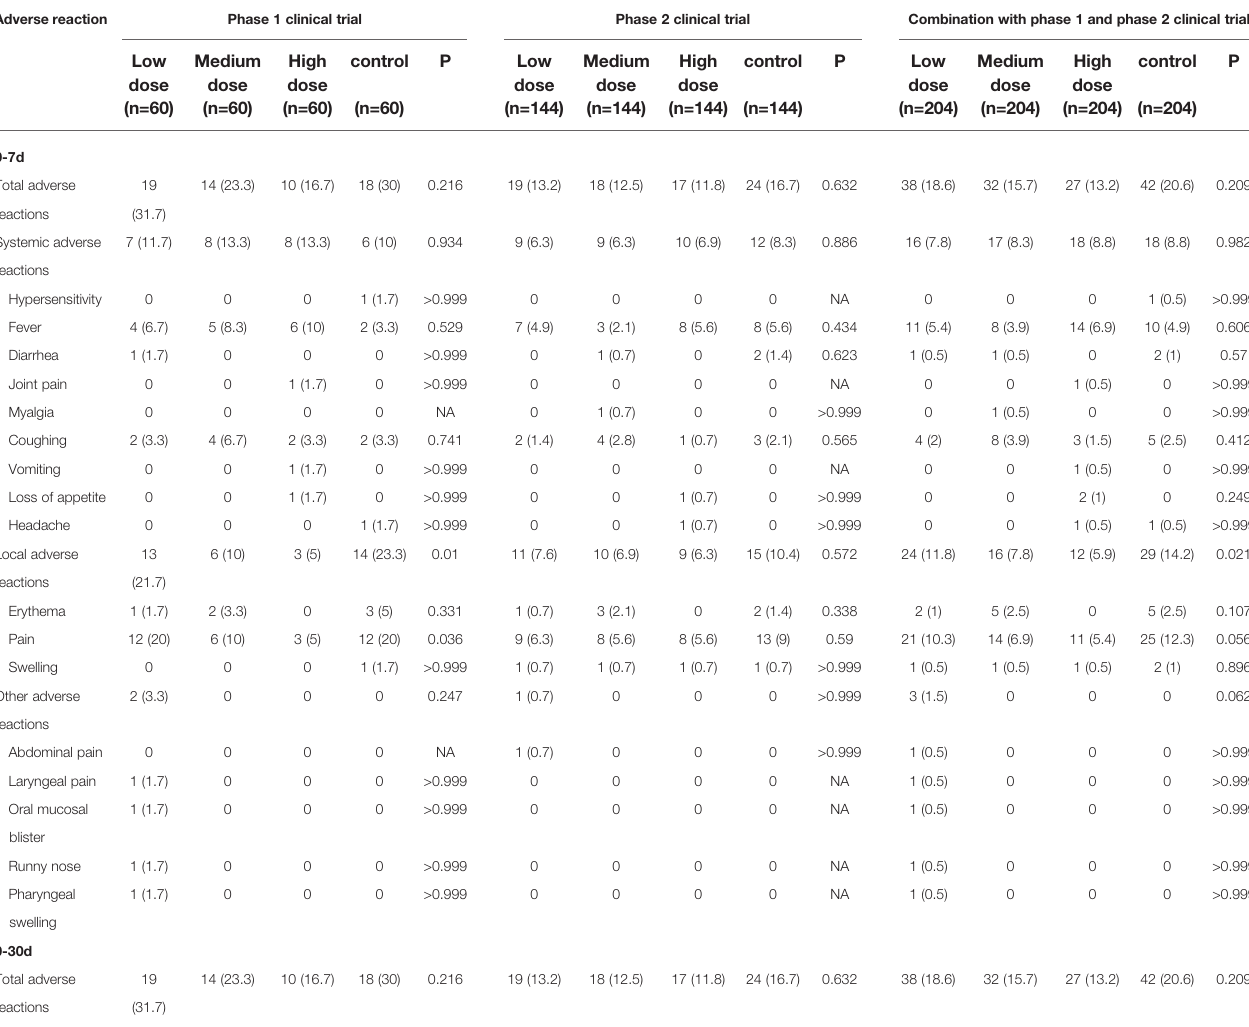
TABLE 2 | Adverse reactions after 3 doses in the phase 1/2 trial a